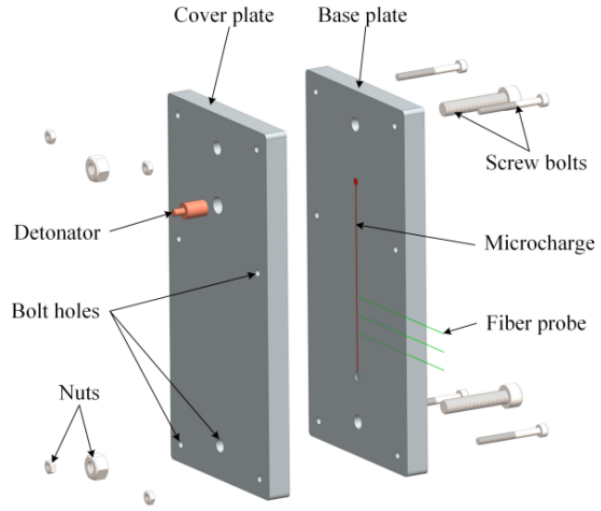
Figure 2. Schematic diagram of the alignment device.